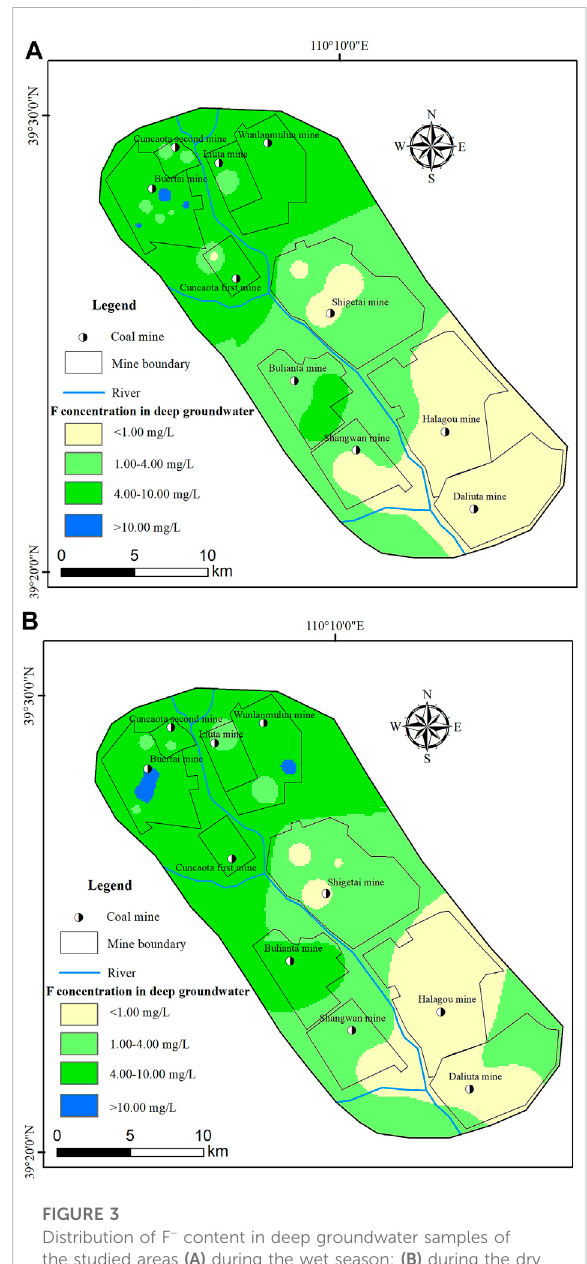
FIGURE 3 Distribution of F − content in deep groundwater samples of the studied areas (A) during the wet season; (B) during the dry